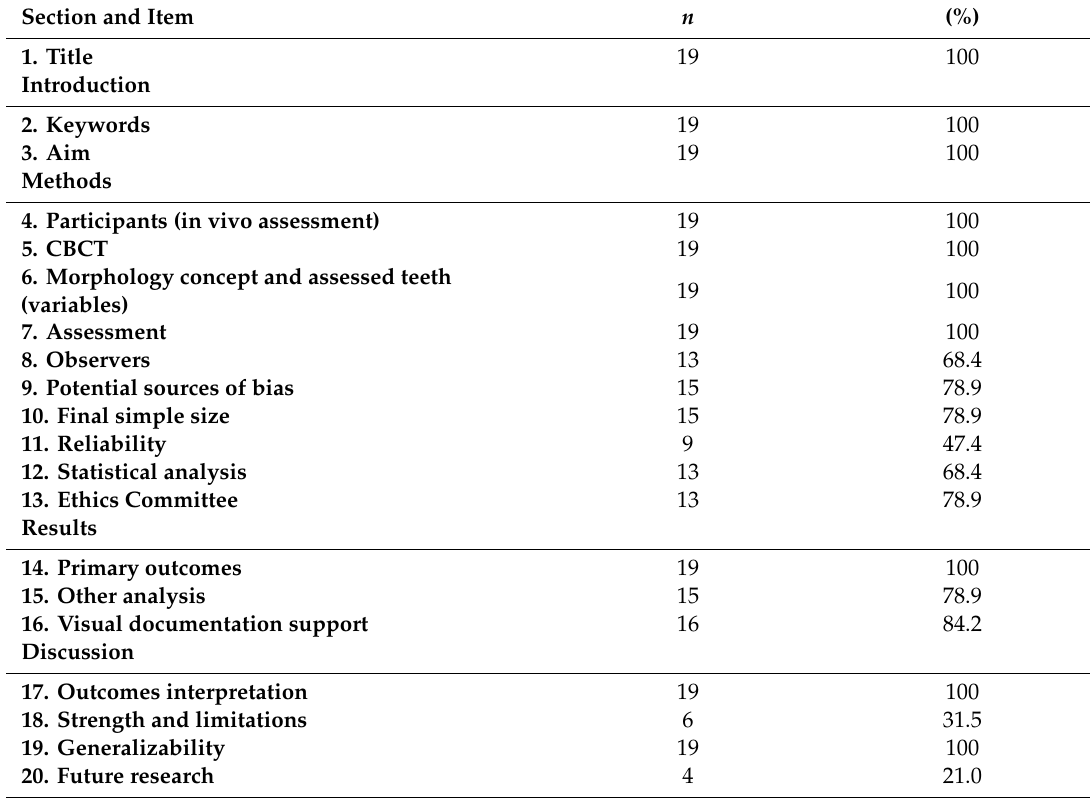
Table 3. Specific Preferred Reporting Items for Cross-sectional Studies on Root and Root Canal Anatomy Using Cone-beam Computed Tomographic